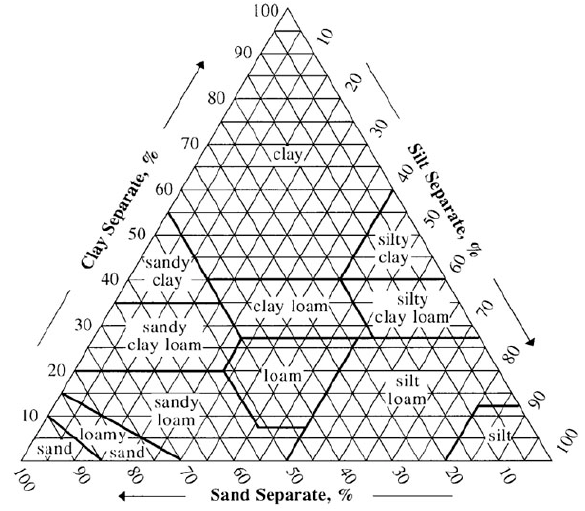
Figure 1. USDA soil textural triangle [36].